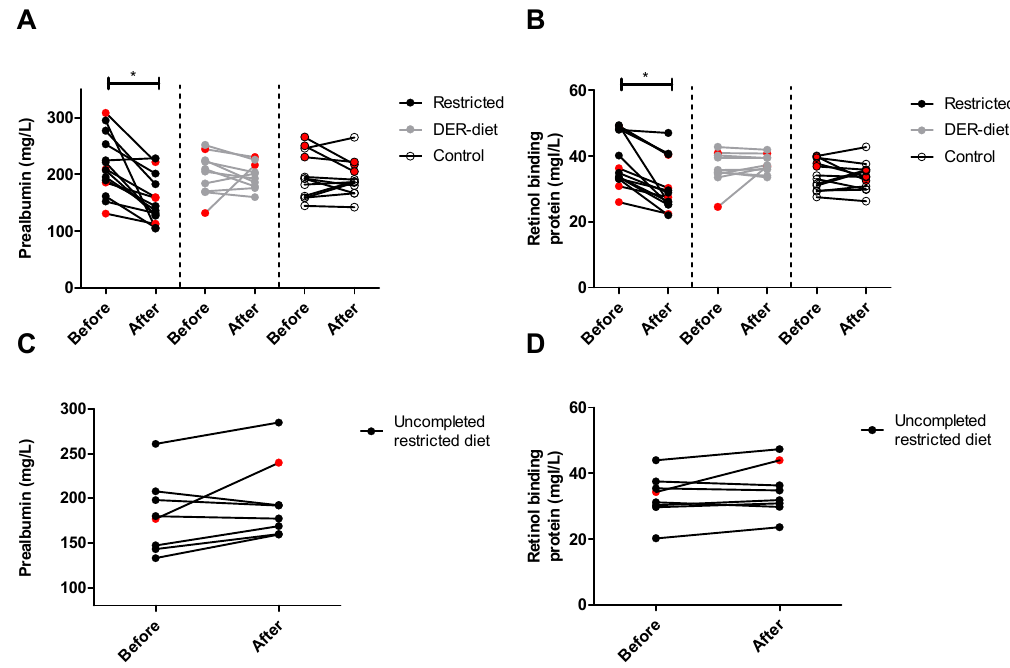
Figure 5. Plasma levels of prealbumin (PAB) and retinol binding protein (RBP) after the three dietary interventions. ( A ) Prealbumin (PAB) and ( B ) retinol binding protein (RBP) both decreased significantly after the restricted diet, with no changes seen in the DER-diet group or in the control group; ( C ) PAB and ( D ) RBP did not change in patients who did not complete the restricted diet. The two corresponding values for the individual patients are connected with a line. * p ≤ 0.002. Red symbols = kidney donors in the restricted diet group. DER = daily energy requirements.